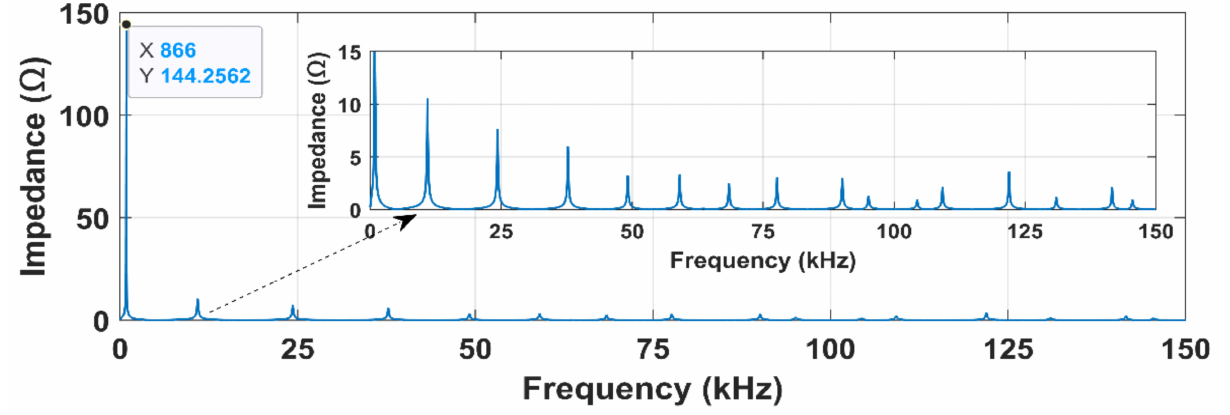
Figure 3. Frequency response without load.